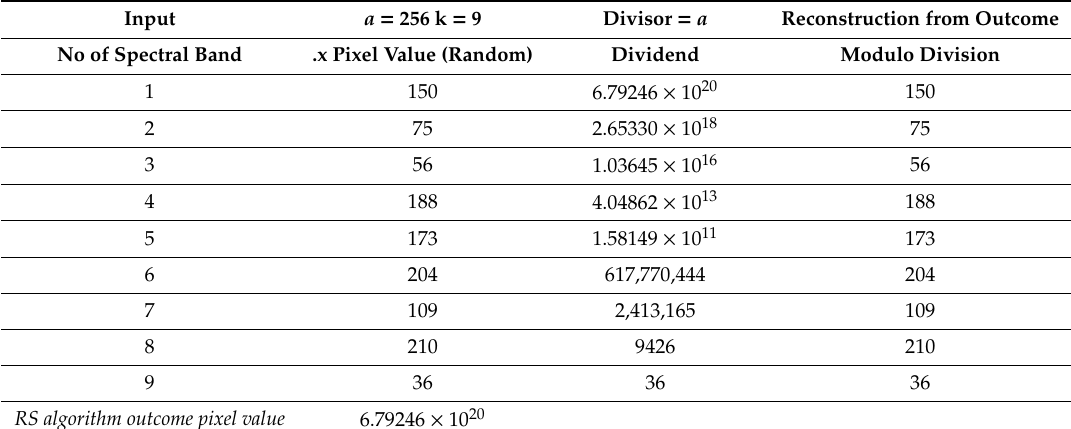
Table 2. Reverse procedure of the RS algorithm resulting pixel value from the random input pixel value for 256 levels of greyscale and 9 spectral bands.